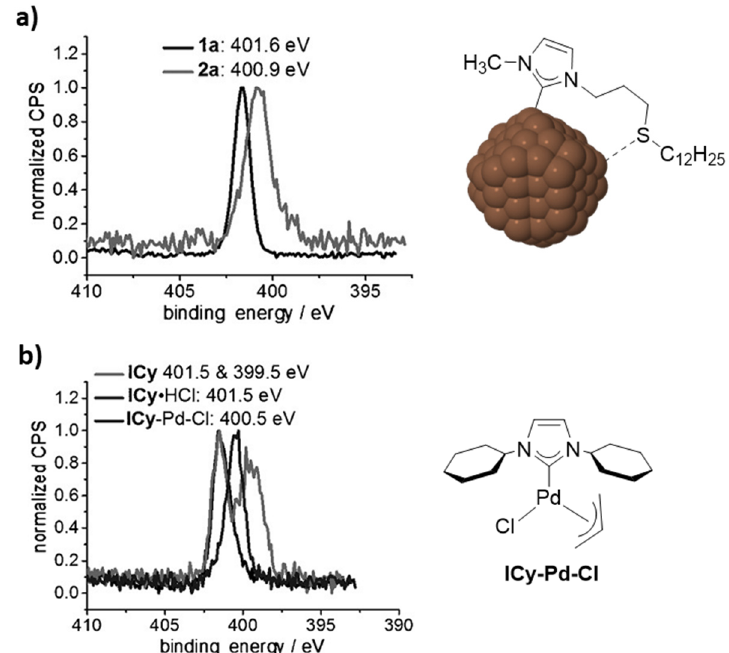
Figure 12. ( a ) Example of XPS for the N 1s signal of a Pd NP and its corresponding imidazolium salt. ( b ) Comparative study of free carbene ICy, HCl · ICy and Pd-ICy complex. Adapted from reference 32 with permission of Willey-VCH.